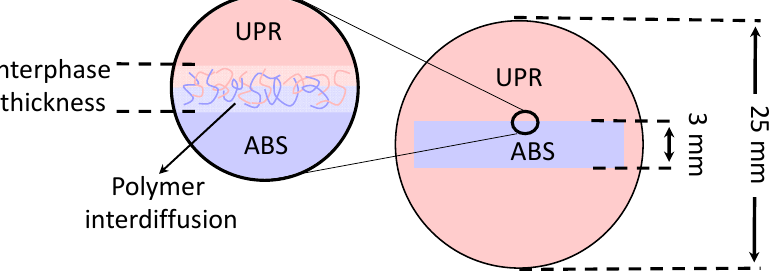
Figure 1. Schematic view of the interphase region in the acrylonitrile butadiene styrene-unsaturated polyester resin (ABS-UPR) co-bonded specimen [31].